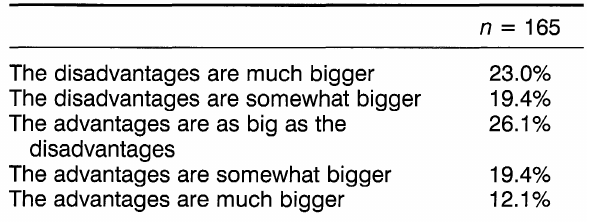
TABLE I. The importance attributed to the development of a predictive test for AD